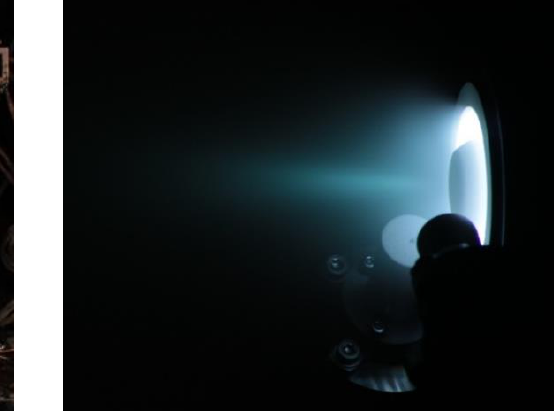
Figure 9. Thruster ignition sequence after the heating transient: currents (left) and voltages (right).